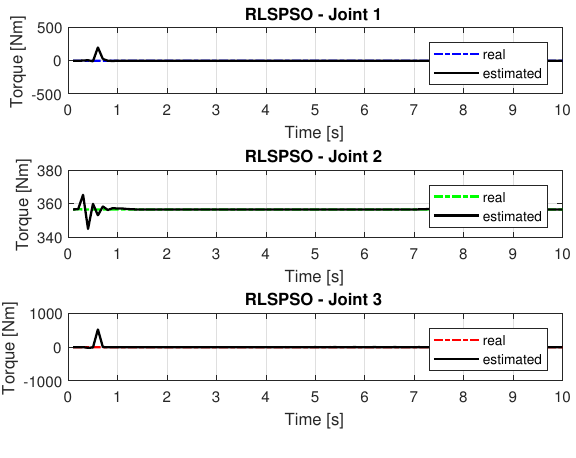
Figure 21. Torque of joints with